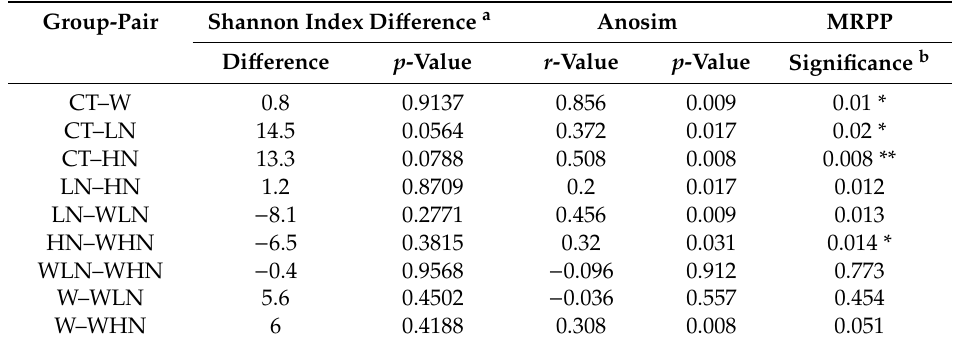
Table 1. Statistical analysis on the group di ff erences of bacterial community